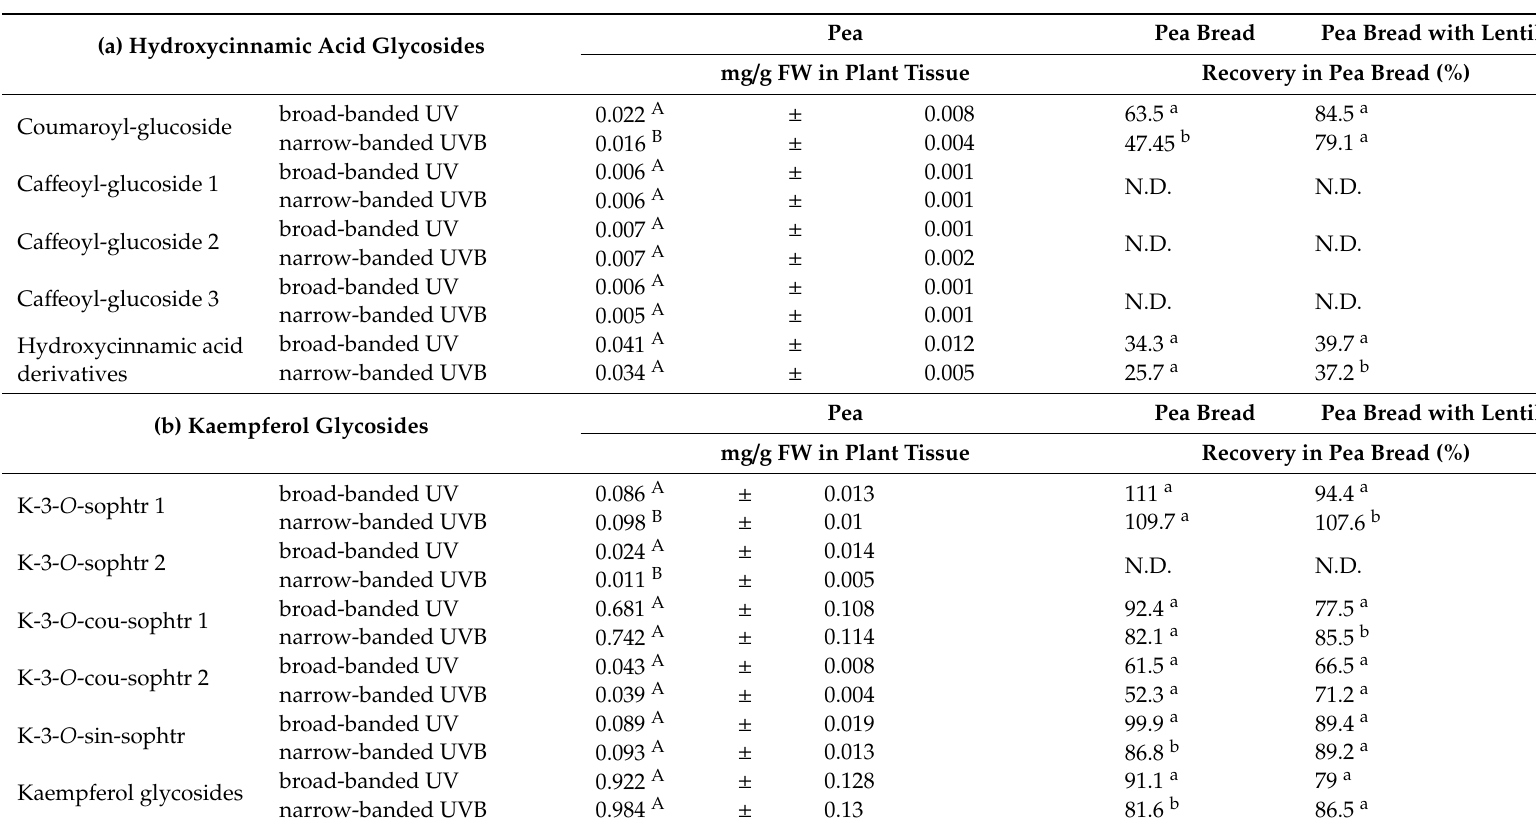
Table 3. Influence of narrow-banded UVB and breadmaking on ( a ) Hydroxycinnamic acid glycosides, ( b ) Kaempferol glycosides, and ( c ) Quercetin glycosides, in pea leaves. Abbreviations: caf: ca ff eoyl; cou: coumaroyl; glc: glucoside; HCA: hydroxycinnamic acids; k: kaempferol; q: quercetin; sin: sinapoyl; soph: sophoroside; sophtr: